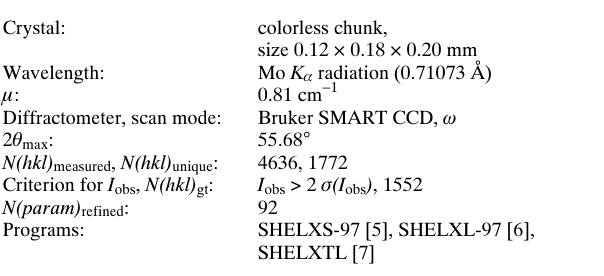
Table 1. Datacollection and handling.